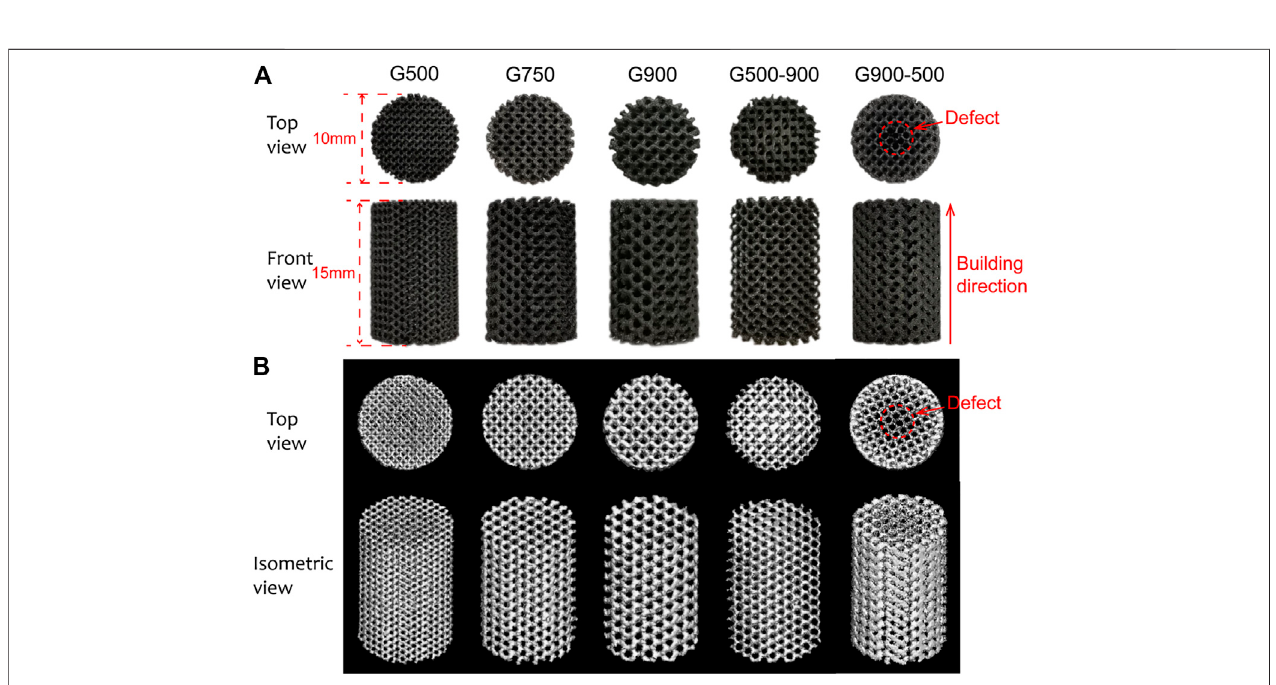
FIGURE 3 | (A) Macroscopic morphologies of Ni 46.5 Ti 44.5 Nb 9 porous scaffolds and (B) micro-CT 3D reconstruction model of the